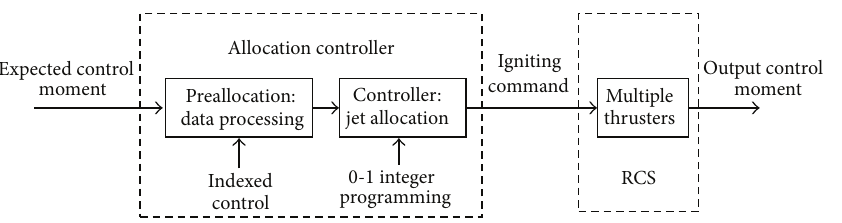
Figure 8: RCS control allocation system diagram.